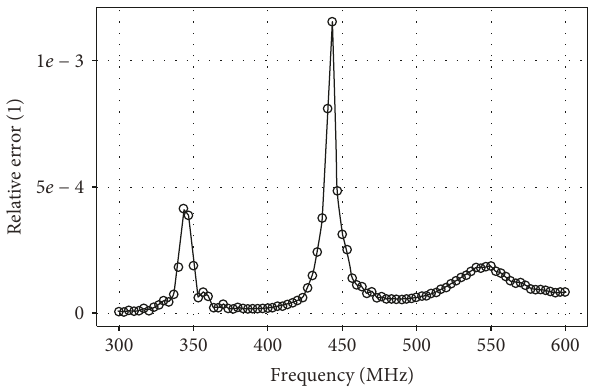
Figure 10: The relative error of the S -parameters between the results of the proposed method and the traditional method. Table 5: CPU time of the traditional method and the proposed method.